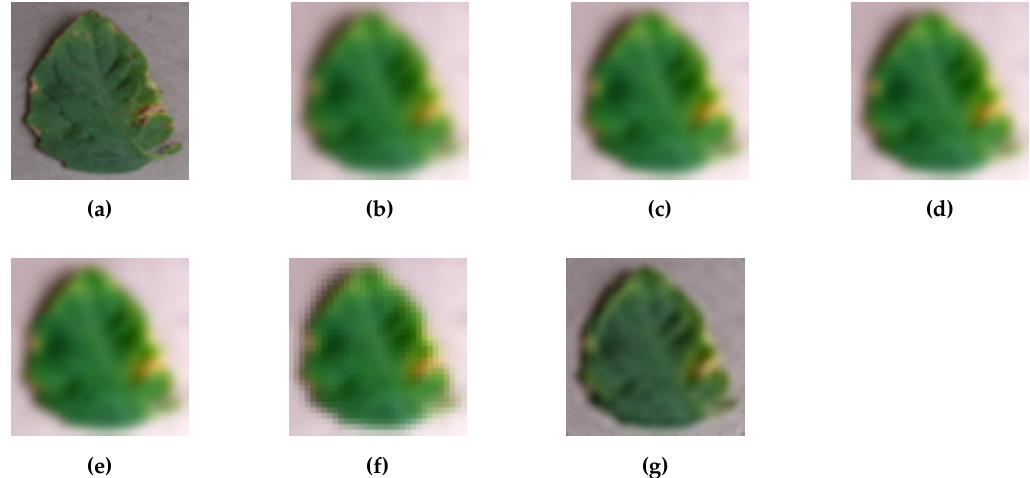
Figure 2. Examples of high-resolution, low-resolution, and super-resolution images. ( a ) Original; ( b ) Bilinear; ( c ) Cubic; ( d ) Bicubic; ( e ) Lanczos; ( f ) NearestNeighbor; ( g )